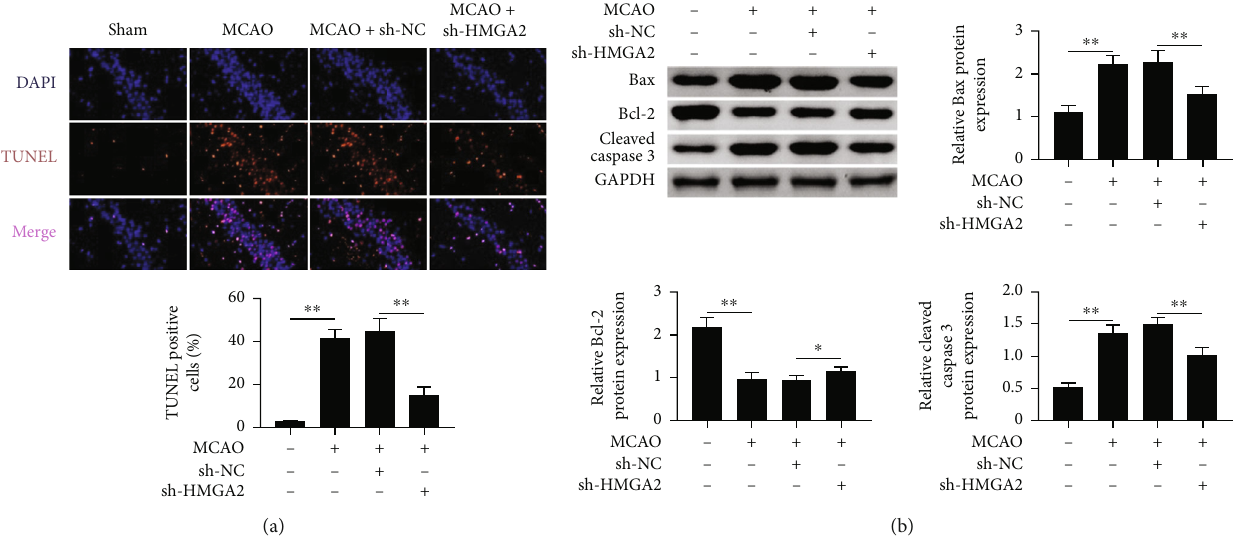
Figure 3: The e ff ects of HMGA2 on brain injury induced apoptosis. (a) Analysis of cellular apoptosis ratio on cerebral infarction rats that transfected with sh-HMGA2 or sh-NC. (b) Western blot was used to explore the protein expression level of apoptosis related protein after cerebral infarction. ∗∗ p < 0 : 01 vs. sham or MCAO + sh-NC. Data are expressed as mean ± SEM